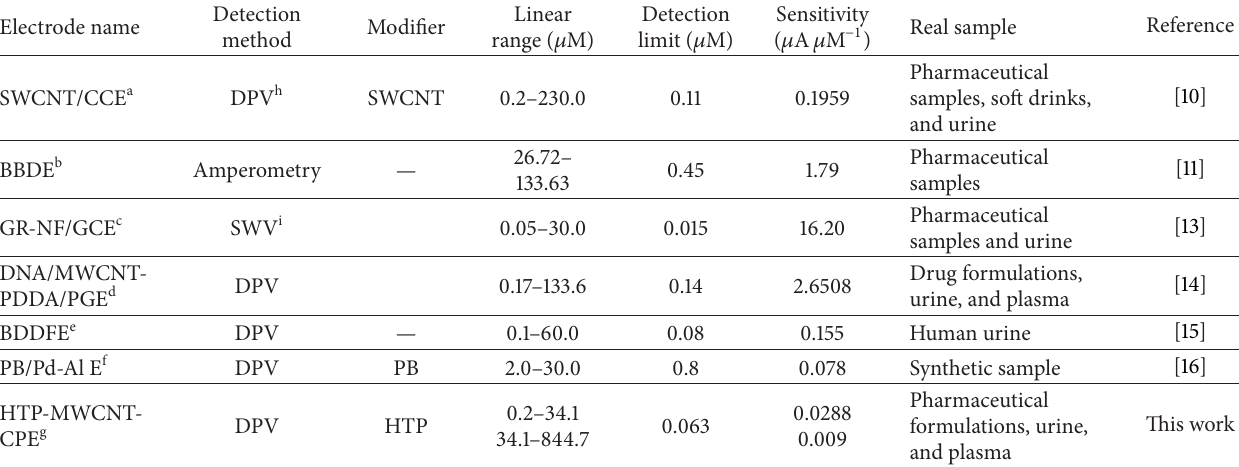
Table 1: Comparison of the efficiency of different modified electrodes for the determination of codeine.